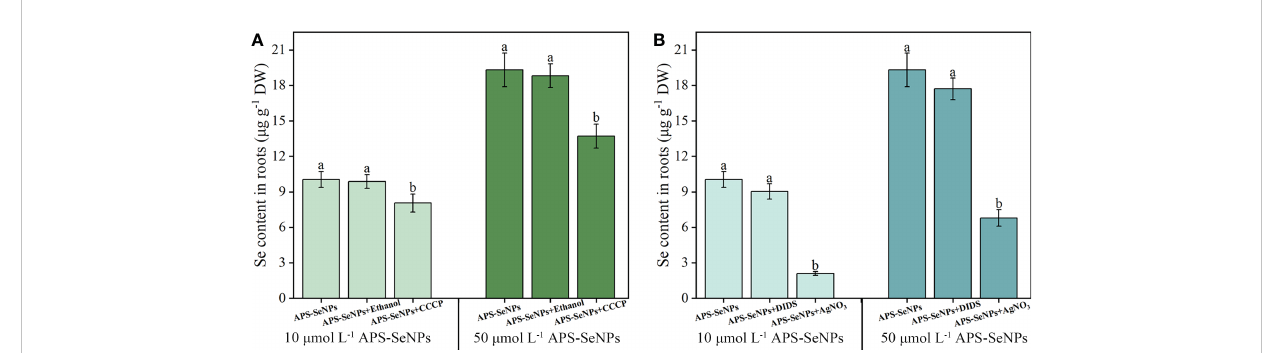
FIGURE 3 Effect of the metabolic inhibitor CCCP (carbonyl cyanide 3-chlorophenylhydrazone) (A) and the anionic inhibitor DIDS (4,4-diisothiocyanatostilbene- 2,2-disulfonic acid disodium salt hydrate) and aquaporin inhibitor AgNO 3 (B) on the in fl ux of different concentrations of algal polysaccharide – selenium nanoparticle (APS-SeNP) into rice roots. Data are presented as the mean ± SE ( n = 4). Different letters indicate signi fi cant differences between treatments at p < 0.05 according to Duncan ’ s